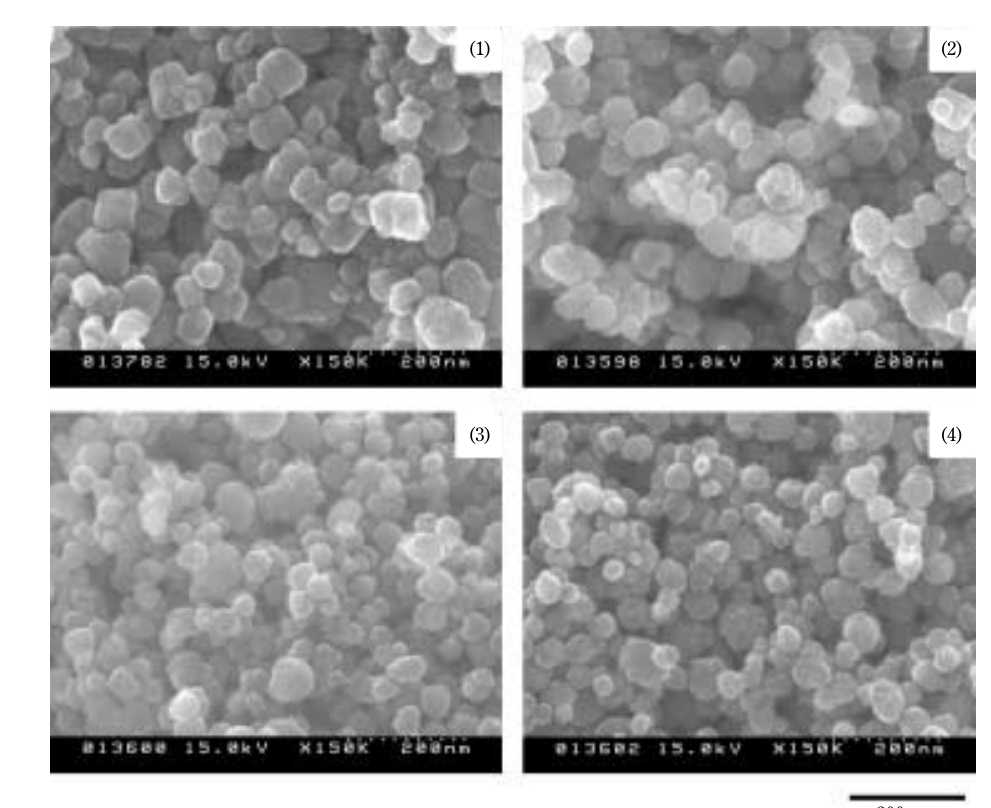
Fig. 5 SEM micrographs of BaTiO 3 particles prepared by different mixing condition: Flow rate (1) 0.12 m/s (2) 0.28 m/s (3) 0.73 m/s (4) 1.24